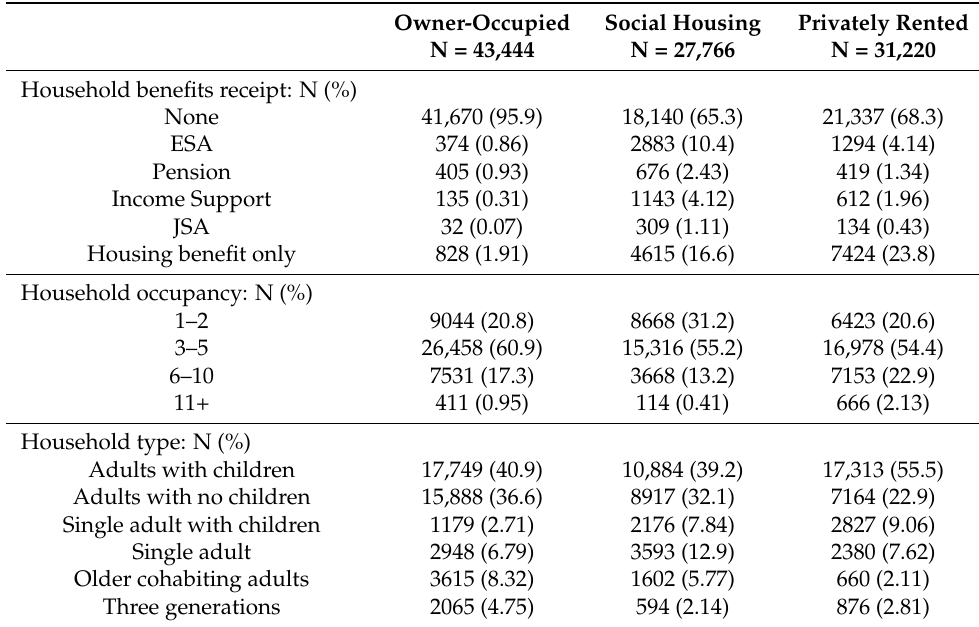
Table A3. Household benefits receipt, occupancy, and household type, by tenure for complete cases (N = 102,430).